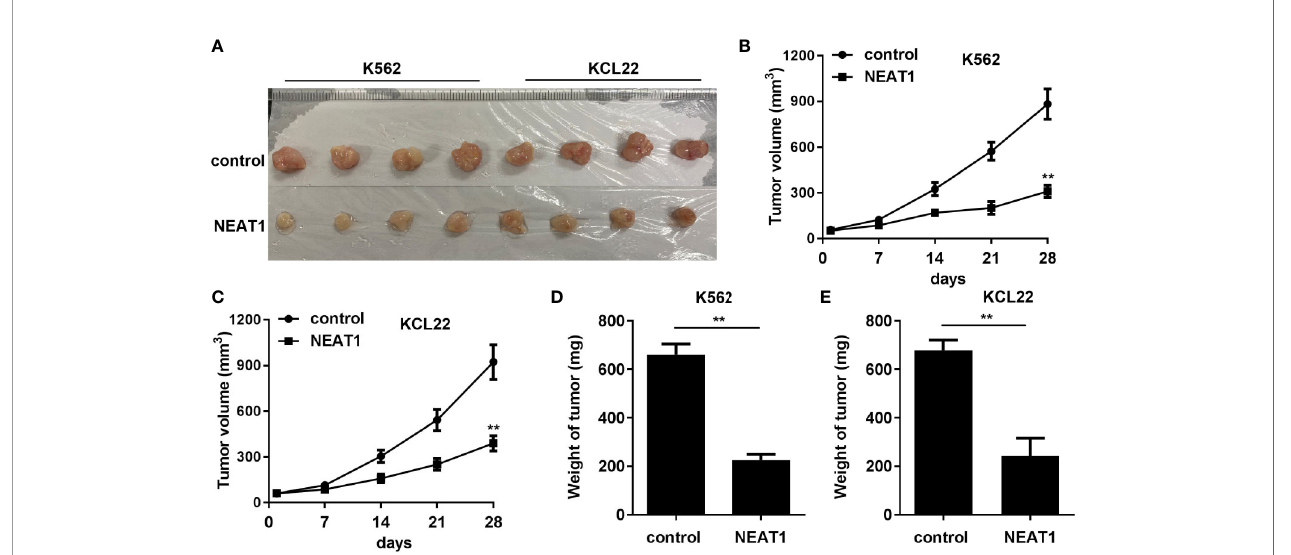
FIGURE 8 | NEAT1 inhibited the growth of CML cells in vivo . (A) The image of tumor in control and NEAT1 group. (B, C) The volume of the tumors was assessed. (D, E) The weight of the tumors was detected. **P < 0.01 vs. control group. NEAT1, lncRNA nuclear enriched abundant transcript 1; NC, negative control; CML, chronic myeloid leukemia;